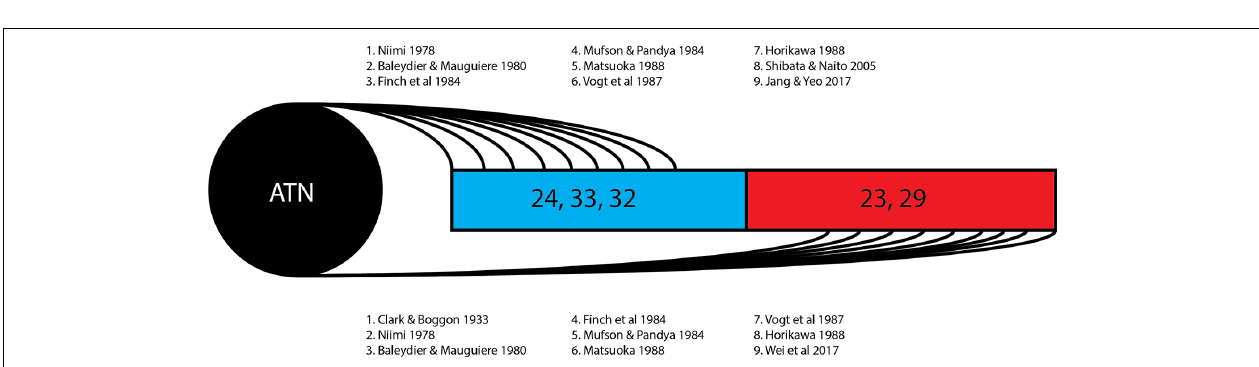
FIGURE 2 | Thalamocingulate tract entry into cingulum. Diagrammatic overview of the quantity of studies showing thalamic connections to each cingular region. Brodmann area 24, 33, and 32 (shown in blue) correspond to the anterior cingulate cortex. Brodmann area 23 and 29 (shown in red) correspond to the posterior cingulate cortex and retrosplenial cortex. ATN, anterior thalamic nucleus.